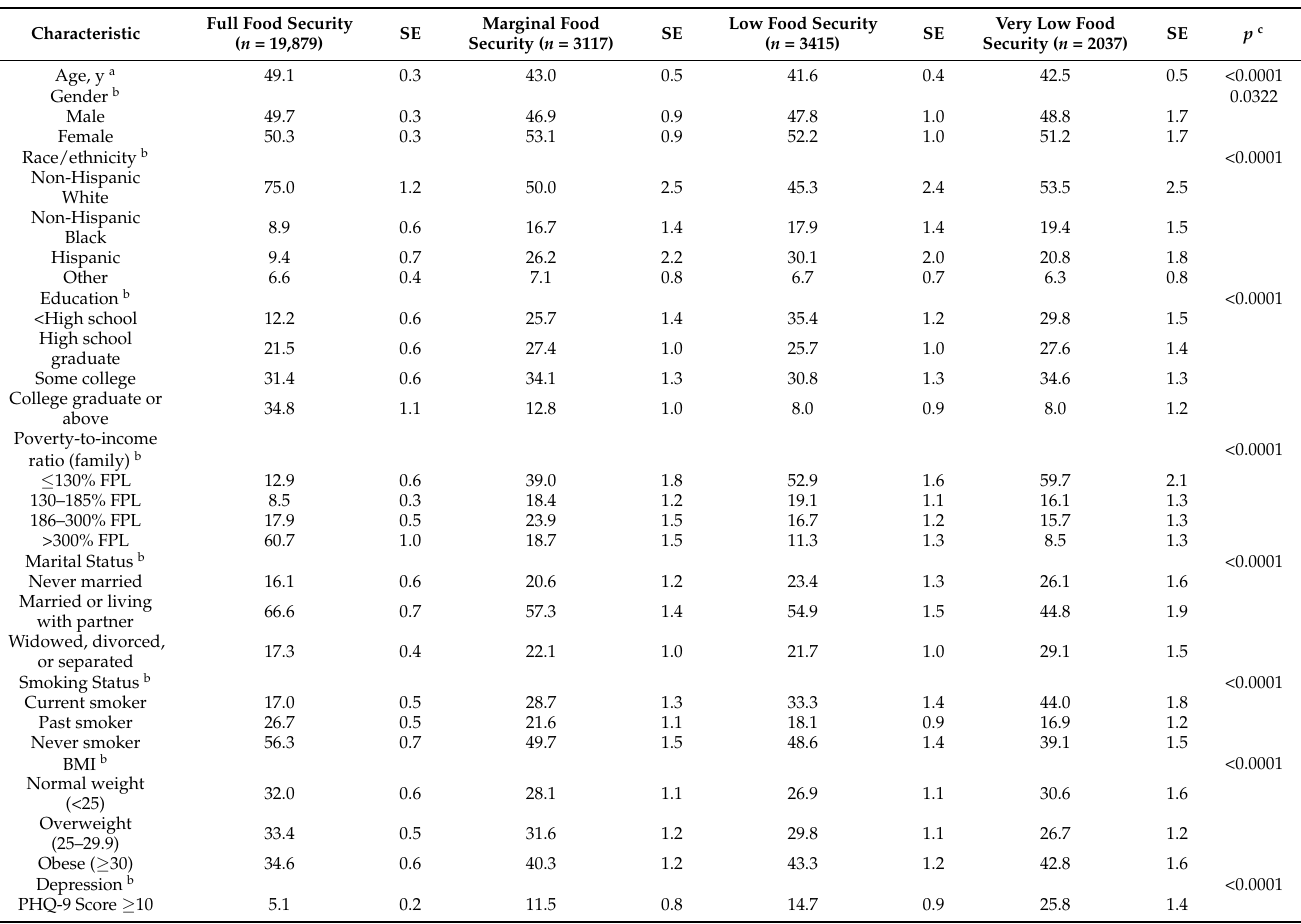
Table 1. Household food security and sociodemographic characteristics: National Health and Nutrition Examination Surveys